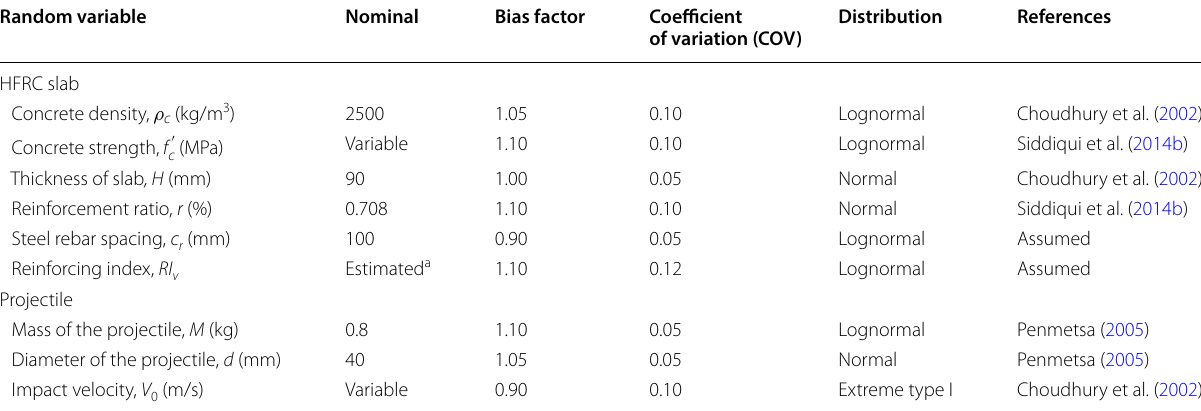
Table 4 Random variables and statistical